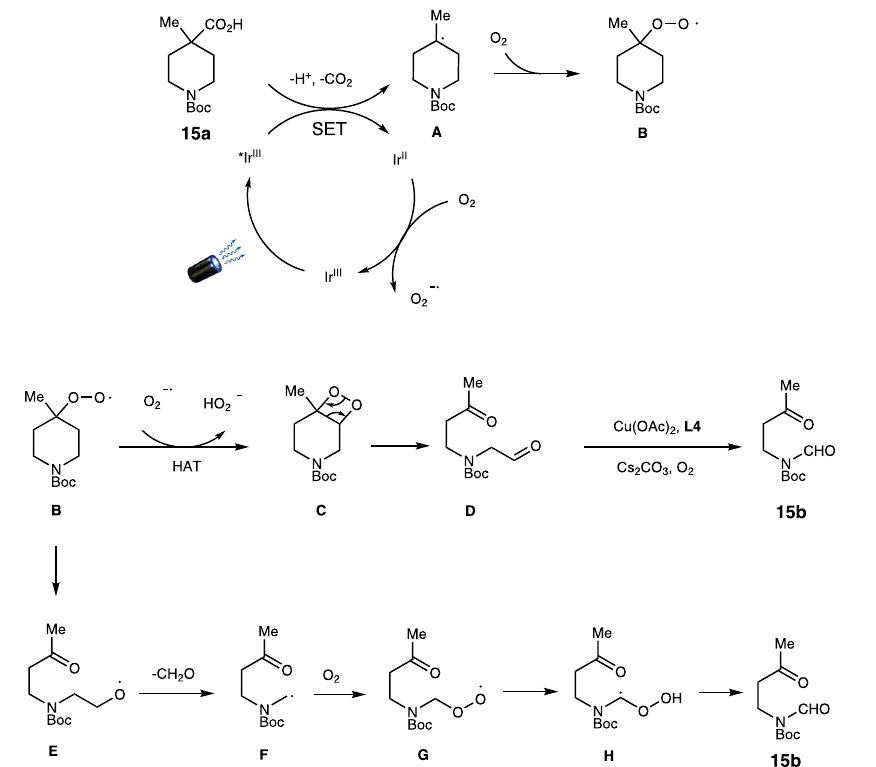
Fig. 9 | Proposed mechanism. The reaction features a decarboxylative oxidation process and might proceed through two different